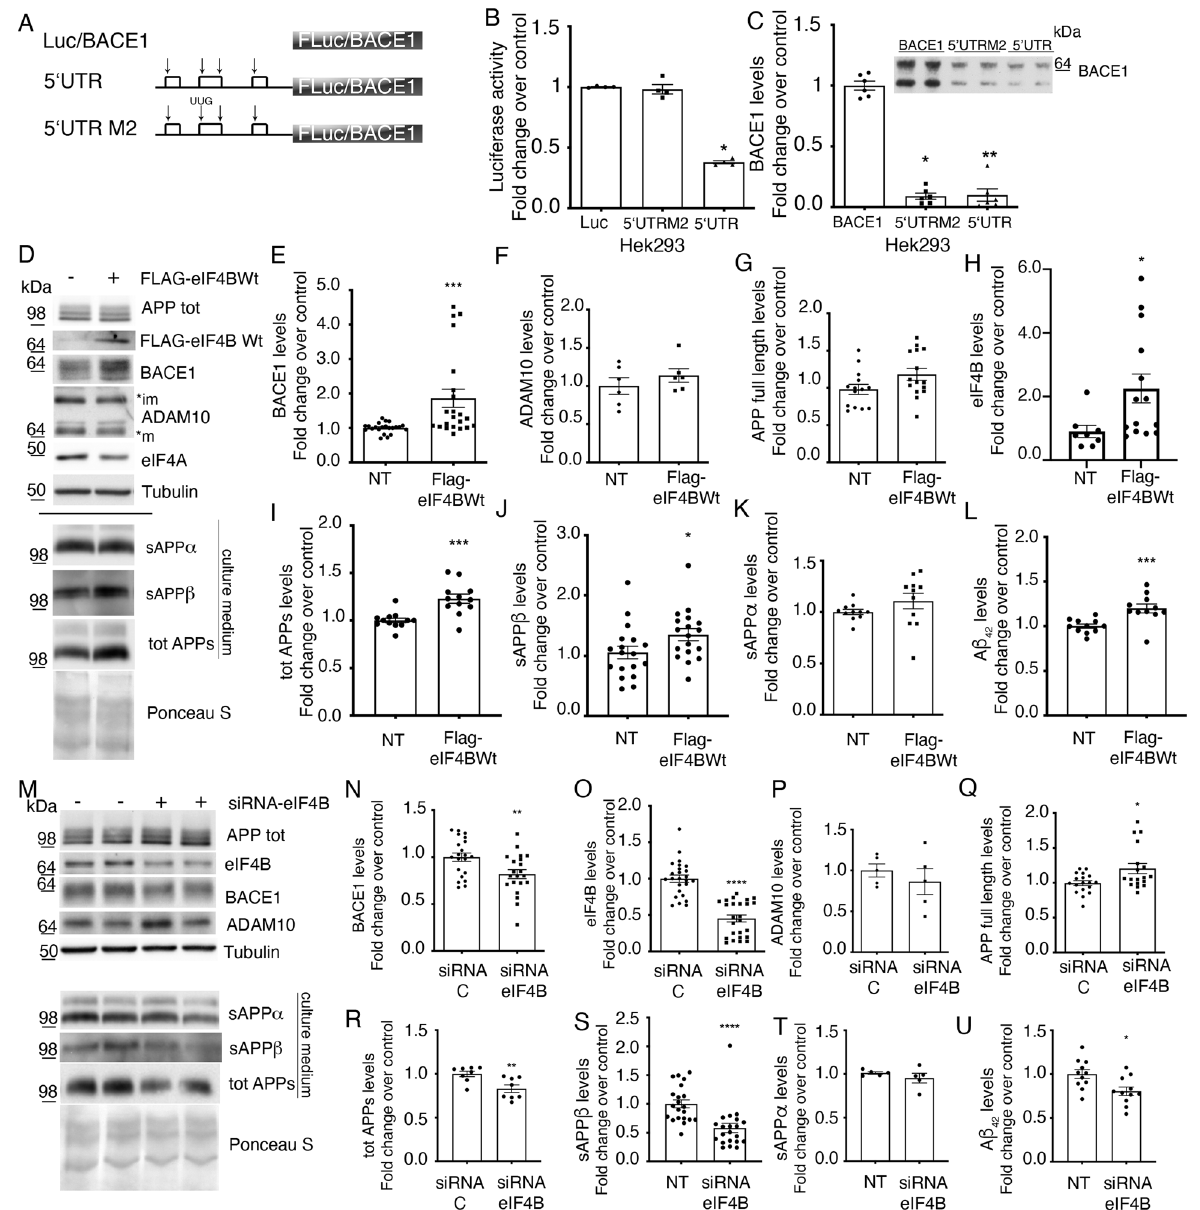
Fig. 1 The presence of BACE1 ORF reinforces the translational inhibition of the 5 ′ UTR. A Schematic representation of the transfected constructs, containing Fire fl y luciferase (FLuc) or BACE1 as reporter gene. White boxes represent uORFs and arrows uAUGs. Mutation of the 2nd uAUG to UUG is indicated. B Luciferase activity measured in total cell extracts of HEK293 cells, co-transfected with the indicated constructs and a plasmid encoding the renilla luciferase. The Fire fl y Luciferase activity was normalized on renilla luciferase activity to account for differences in transfection ef fi ciencies and data represent the mean ± SEM of at least three independent experiments, expressed as fold change over control (luciferase). C Quanti fi cation of BACE1 levels by western blot (inset) in total cell extracts of HEK293 cells, co-transfected with the indicated constructs and a plasmid encoding Fire fl y luciferase, to normalize for transfection ef fi ciency. Total cell extracts were subjected to luciferase activity measurement and to SDS-PAGE followed by western blot analysis with anti-BACE1 antibody. Blots were then stripped and reincubated with anti-Calnexin antibody as loading control. The intensities of BACE1 band signals were quanti fi ed and normalized for loading and for transfection ef fi ciency (on luciferase activity). Results are presented as mean±SEM of at least three independent experiments, with protein levels shown as fold change over control (BACE1). D – T eIF4B overexpression or silencing modulates the expression of BACE1. Hippocampal neurons were transfected for 96 h either ( D ) with wild-type eIF4B (FLAG-eIF4BWt) or an empty vector (NT) or ( L ) with a control or an eIF4B siRNA pool. E – L ; N – T Representative western blot and quanti fi cation of the indicated proteins are shown. BACE1, ADAM10, eIF4B, full-length APP (lysate), total soluble APP, soluble APP α , or β (culture medium) signals were quanti fi ed and normalized for loading (Tubulin for cell extracts, Ponceau S staining for cell culture supernatants). H Overexpressed eIF4B levels in transfected neurons were quanti fi ed as the sum of endogenous and overexpressed protein. L , U ELISA measurement of A β 42 levels. Results are presented as mean ±SEM of at least three independent experiments, with protein levels shown as fold change over control (cells transfected with empty vector or with control siRNA pool). Statistical signi fi cance was calculated using Kruskal – Wallis one-way analysis of variance followed by Dunn ’ s post hoc test ( B , C ), two-tailed Student ’ s t -test ( J , N , R , U ) or Mann – Whitney U test ( E , H , I , L , O , Q , S ) ( B : n = 4 p = 0.0145; C : n = 4 p = 0.0145; E : n = 10 p = 0.0003; H : n = 8 p = 0.0113; I : n = 8 p = 0.0005; J : n = 8 p = 0.0485; L : n = 8 p = 0.0006; N : n = 12 p = 0.0082; O : n = 12 p < 0.0001; Q : n = 12 p = 0.0499; R : n = 8 p = 0.0066; S : n = 8 p < 0.0001; U : n = 8 p = 0.0101. * P < 0.05; ** P < 0.01; *** P < 0.001; **** P <